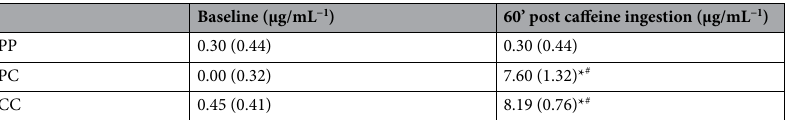
Table 1. Analysis of blood caffeine concentration (n = 14). Median (interquartile deviation) of caffeine concentration with 3 experimental conditions: Placebo–Placebo (PP), Placebo–Caffeine (PC) and Caffeine– Caffeine (CC). *Significantly different from baseline ( P < 0.05). # Significantly different from PP ( P < 0.05).